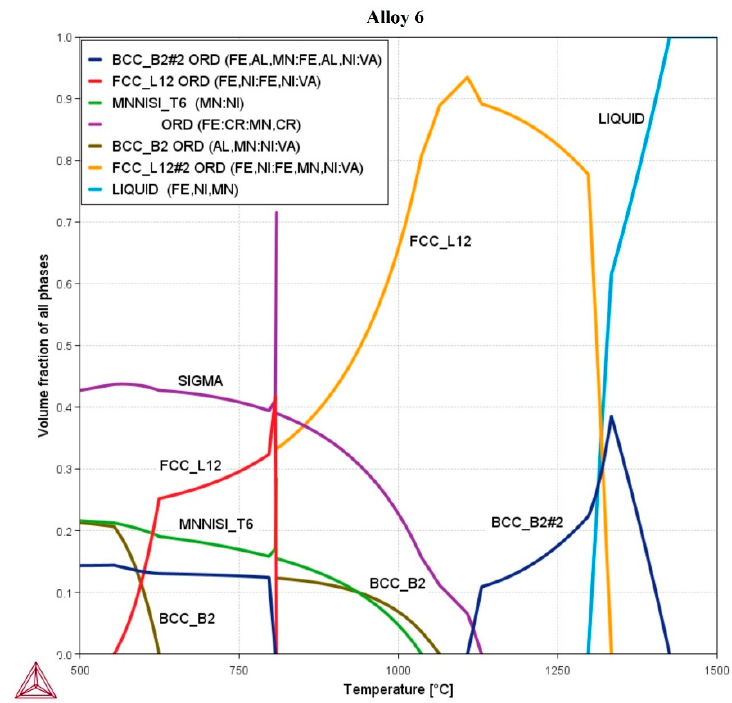
Figure 7. Phase diagram of Alloy 6 (Fe 36 Mn 20 Ni 20 Cr 16 Al 5 Si 3) HEAs.